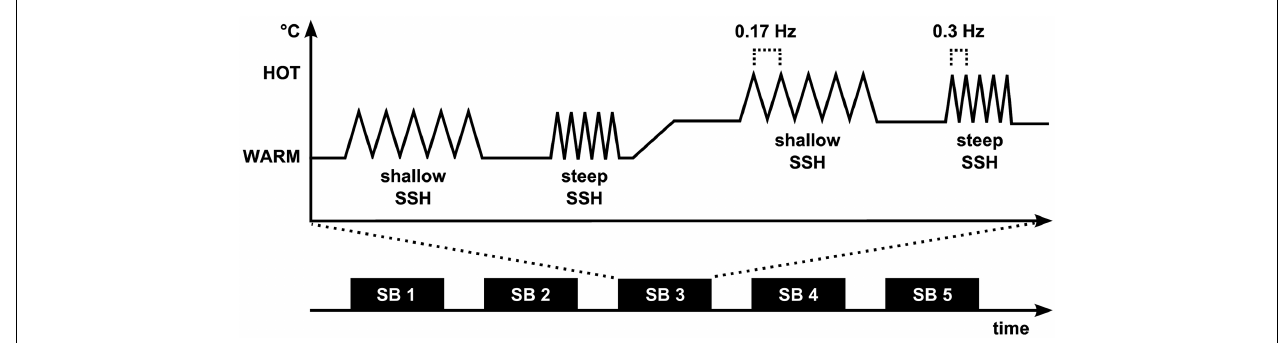
stimuli were applied with a frequency of 0.3Hz whereas painful heat peaks of the stimuli with shallow SSH were applied with a frequency of 0.17Hz. During Experiment 2, shallow and steep SSH were applied only for the hot